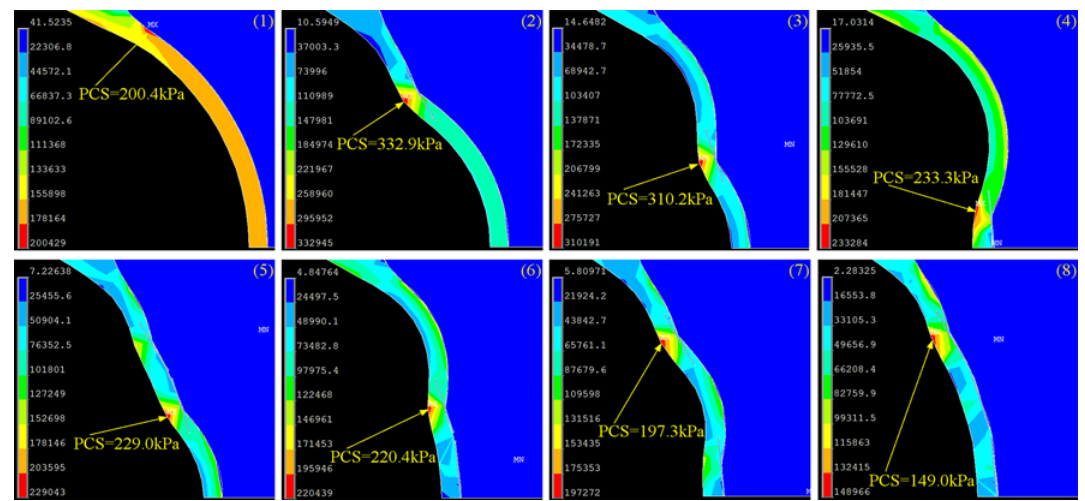
Fig 10. Summary of the Cap Stress in Eight Idealized Models with Non-linear Solutions. (1) Cap stress without cholesterol crystals. (2) Cap stress with one cholesterol crystal at the cap shoulder. (3) Cap stress with one cholesterol crystal halfway between the shoulder and cap center. (4) Cap stress with one cholesterol crystal at the cap center. (5) Cap stress with cholesterol crystals located at the shoulder and halfway between the shoulder and cap center. (6) Cap stress with cholesterol crystals located halfway between the shoulder and cap center and at the cap center. (7) Cap stress with two cholesterol crystals at the cap shoulder and at the cap center. (8) Cap stress with three cholesterol crystals located at three positions.